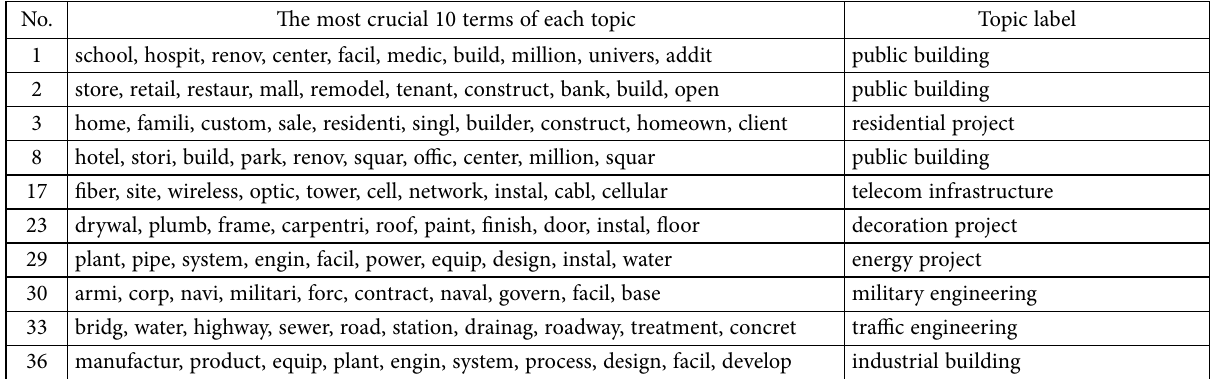
Table 1. The most crucial 10 terms of each topic (construction project type) No.